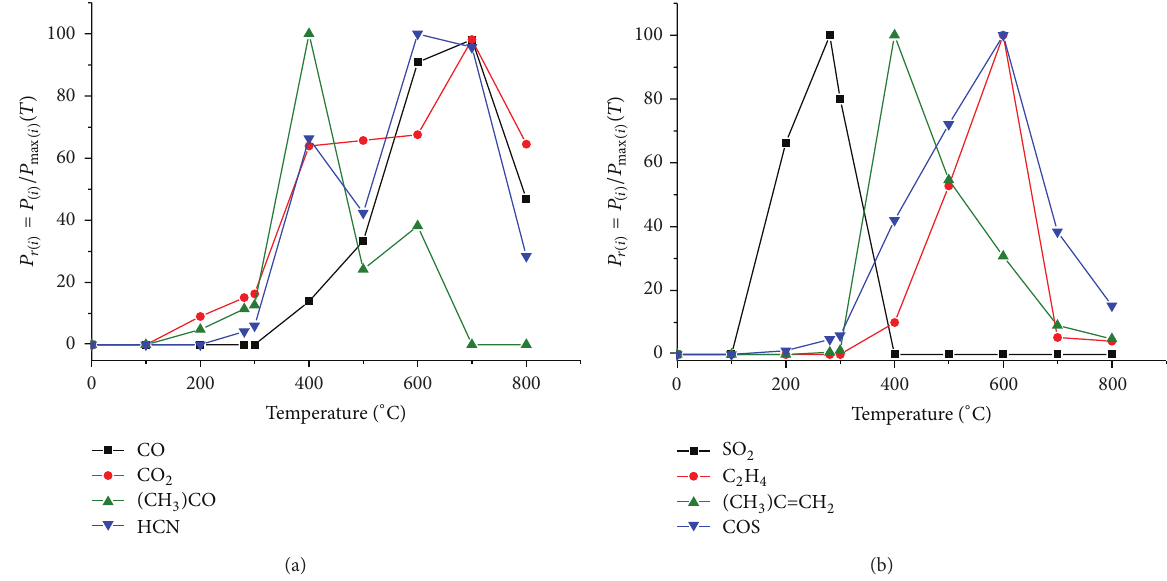
Figure 8: (a) Relative pressure values of (CH 3 ) 2 CO, HCN, CO, and CO 2 against temperature for Sulcis coal. (b) Relative pressure values of (CH 3 ) 2 C=CH 2 , SO 2 , C 2 H 4 , and COS against temperature for Sulcis coal.